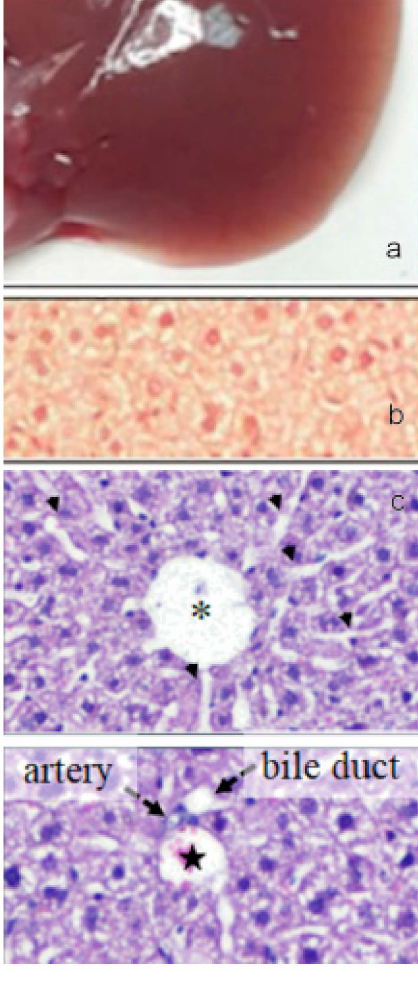
Figure 12. ( a ) Image of the gross morphology of the liver showing normal anatomical features in the control group. ( b ) Picrosirius red staining of liver sections: no evidence of collagen deposition in the parenchyma. ( c ) Hematoxylin-eosin staining of liver sections: normal parenchyma architecture with sinusoids (upper image) along with the portal triad (lower image), composed by a branch of the hepatic artery, a branch of the portal vein, and the bile duct. Asterisk indicates the central vein and star indicates the portal vein. Bar 50 µ